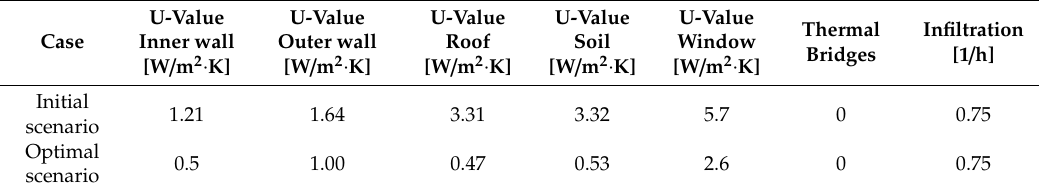
Table 6. Description of the optimal results in the heating mode.